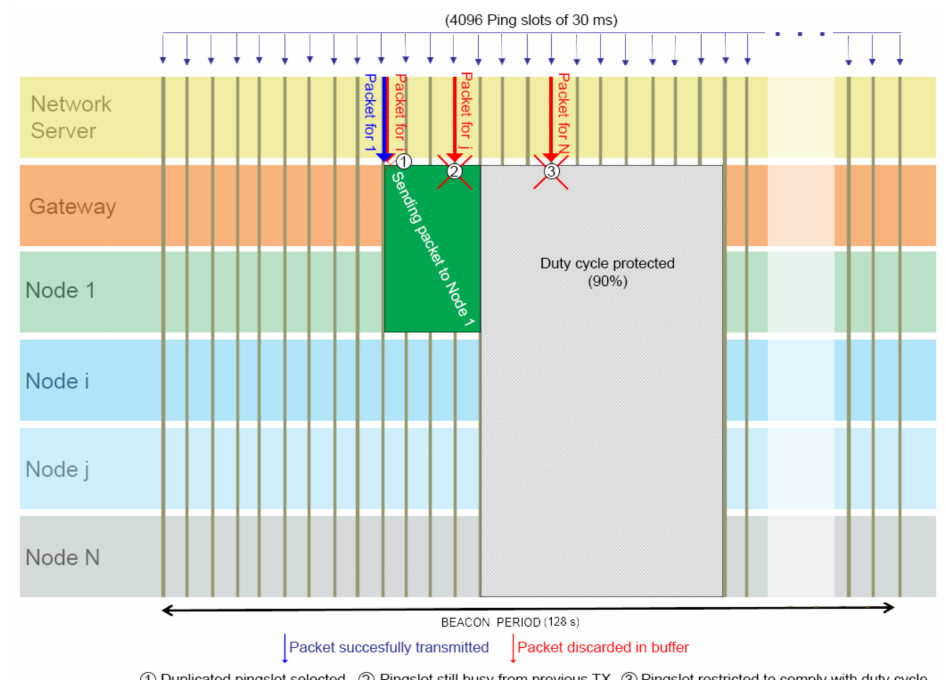
Figure 2. Possible events affecting downlink